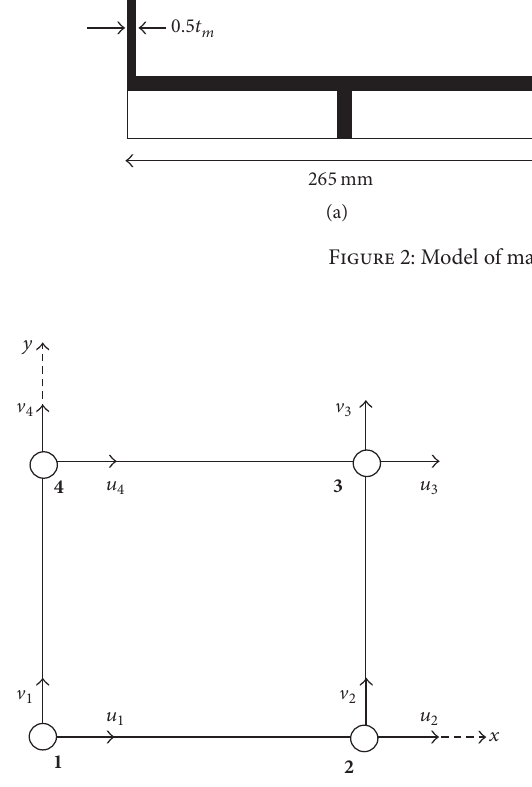
Figure 3: Finite element Q4 used in numerical analysis. Table 2: Material parameter for brick and mortar.